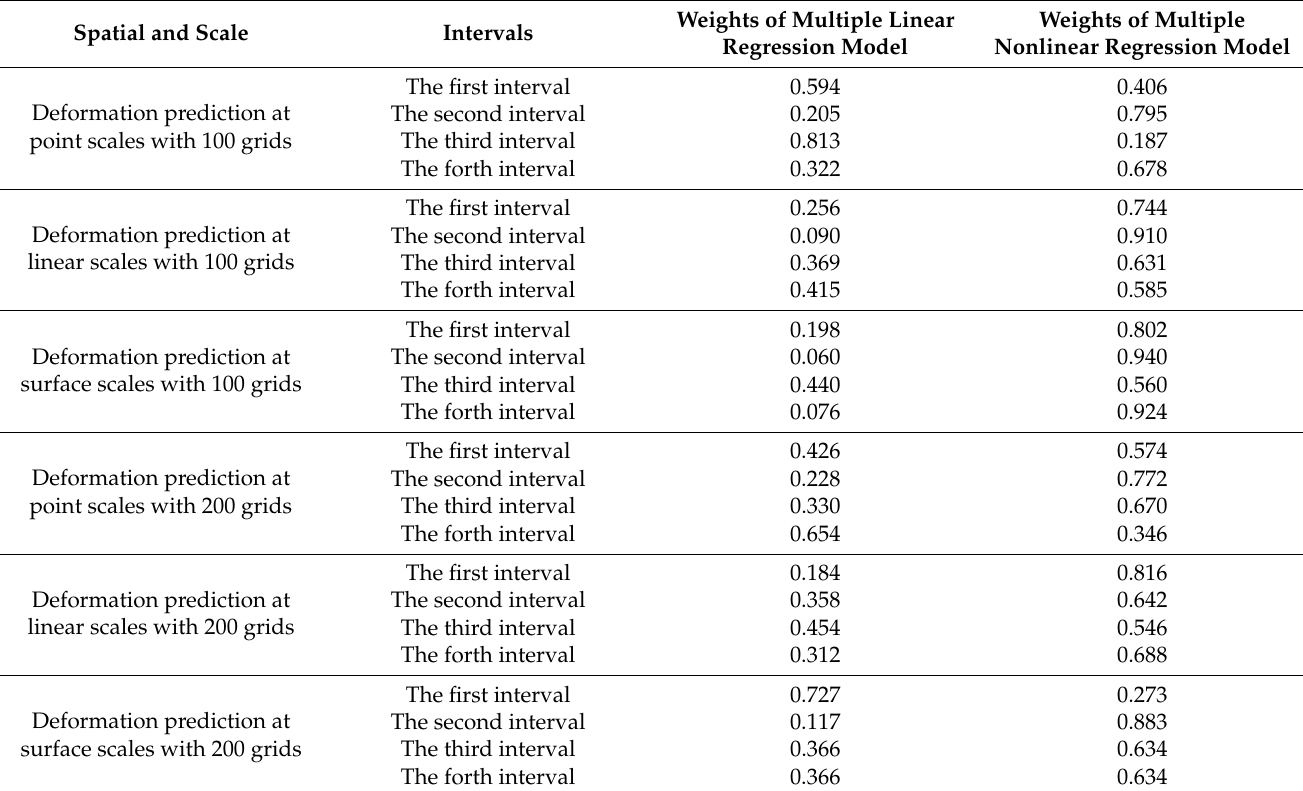
Table 1. The weights assigned by the goodness-of-fit weight model.